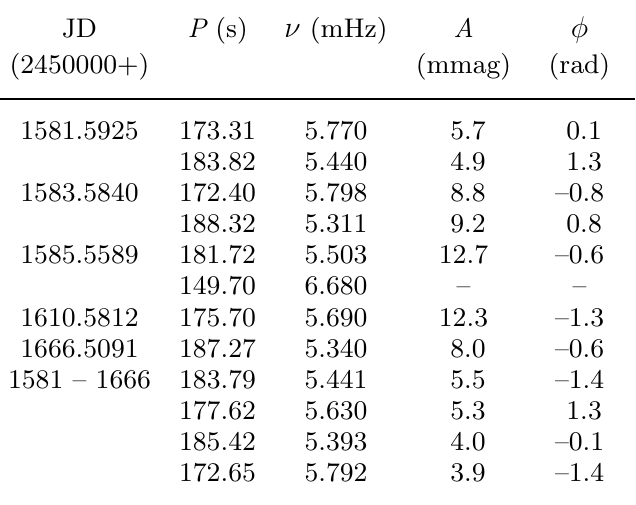
Table 4. The highest periodogram peaks for PG